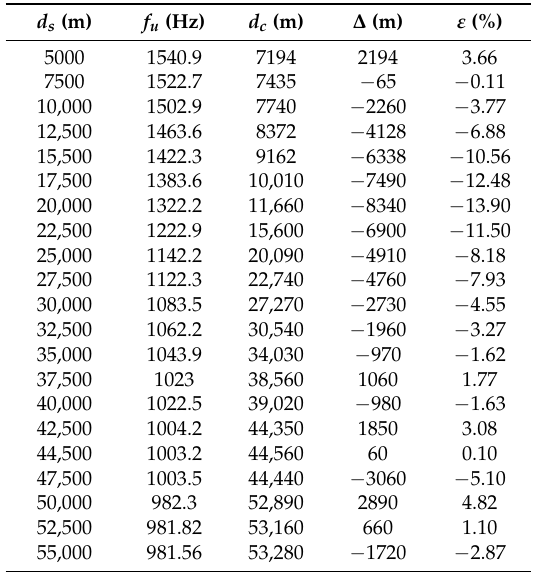
Table 2. Calculated Error of the Fault Location by Analytical Method Applied to the